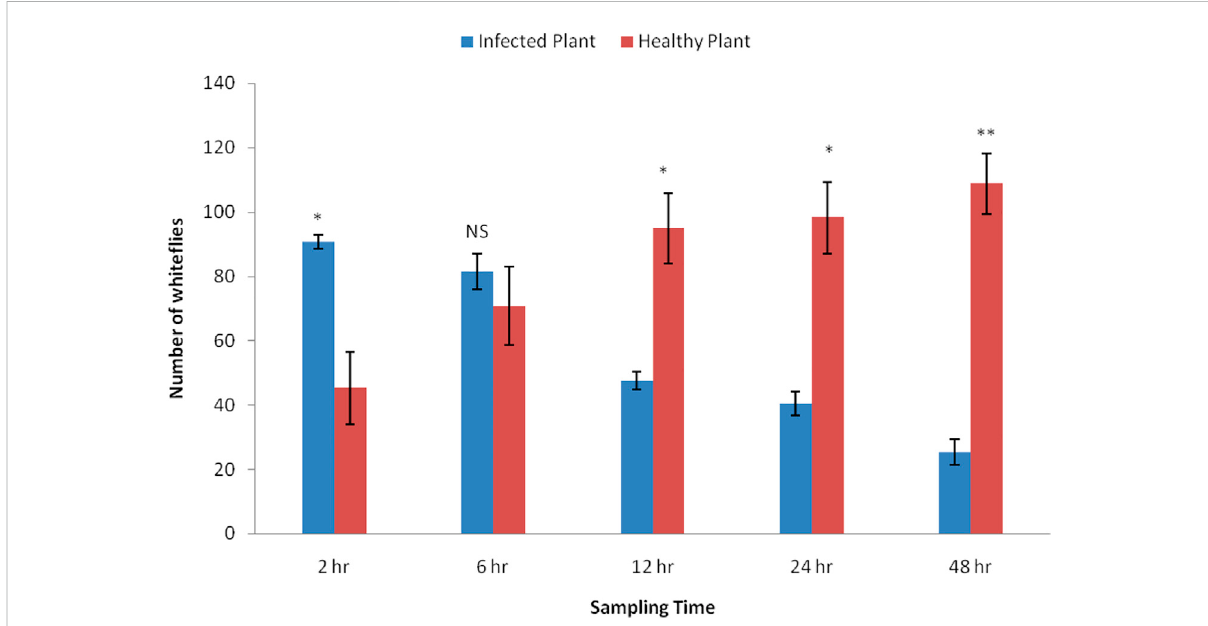
FIGURE 2 Comparative settlingresponseofwhite fl y, Bemisiatabaci onHealthyVs.CLCuVinfectedCottonplantsThevaluesindicatethemeannumberof white fl ies settled per plant by choice method (N = 150). Bars displayed with asterisks denote signi fi cant responses (* p < 0.05, ** p < 0.01, NS-non signi fi cant; two-tailed paired t -test).